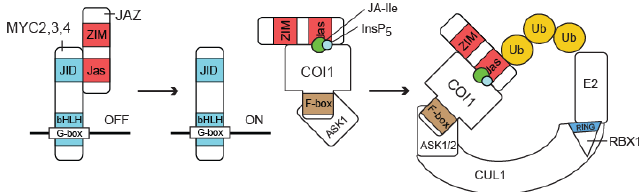
Figure 2. Overview of the core JA-signaling pathway. In the absence of JA-Ile, the activity of the TFs MYC2/3/4, bound to the G-box of JA-responsive promotors, is repressed by interaction with a JAZ protein that binds to the JAZ-interacting domain (JID) of MYC2/3/4 through their Jas domain. Upon perception of the hormone (green dot) by the co-receptor complex composed of a JAZ protein and the F-box component COI1 (SCF COI1 ), which is potentiated by inositol pentakisphosphate (InsP5, blue dot), the CUL-RING E3 ligase (CRL) binds with SCF COI1 and ubiquitinates the JAZ protein. Subsequently, JAZ proteins are degraded and MYC2/3/4 activate transcription of JA-responsive genes eventually resulting in a JA response. Figure adapted from Pauwels and Goossens